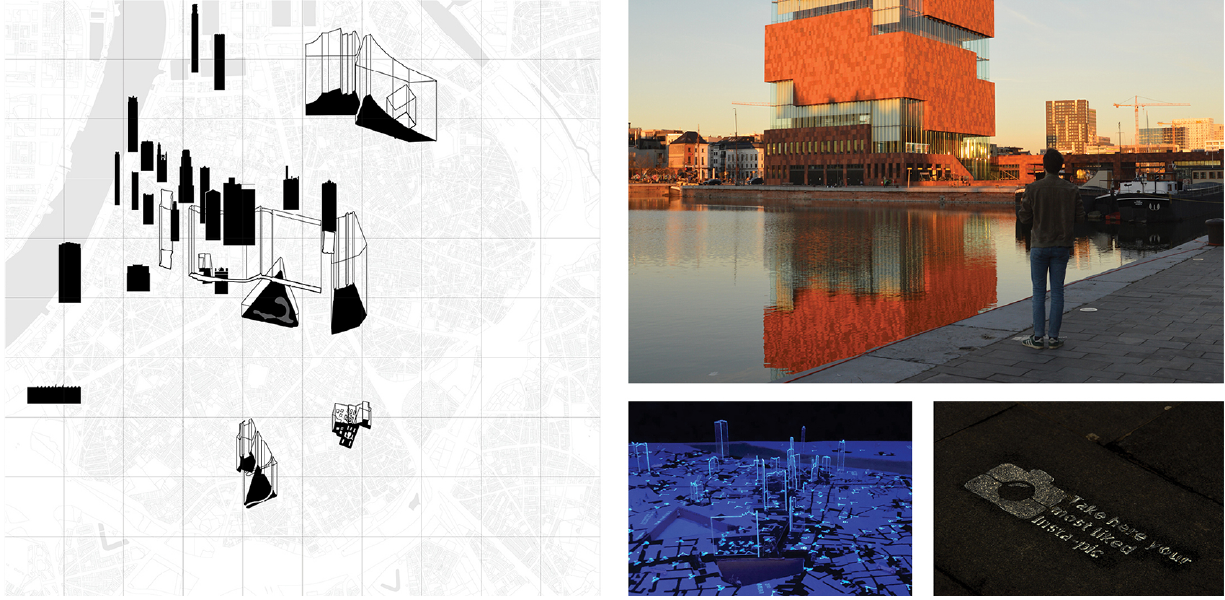
Figure 5. ‘Digital monuments.’ Left: Map—An image of some of Antwerp’s most digitally present icons and public spaces. Above right: The MAS Museum, one of the most digitally present monuments. Below right, from left: Depiction of digital monuments in the ‘Analogue City’ map; street painting marking the data point of the map. Source: The ‘Analogue City,’ IDW University of Antwerp 2019 students, and the